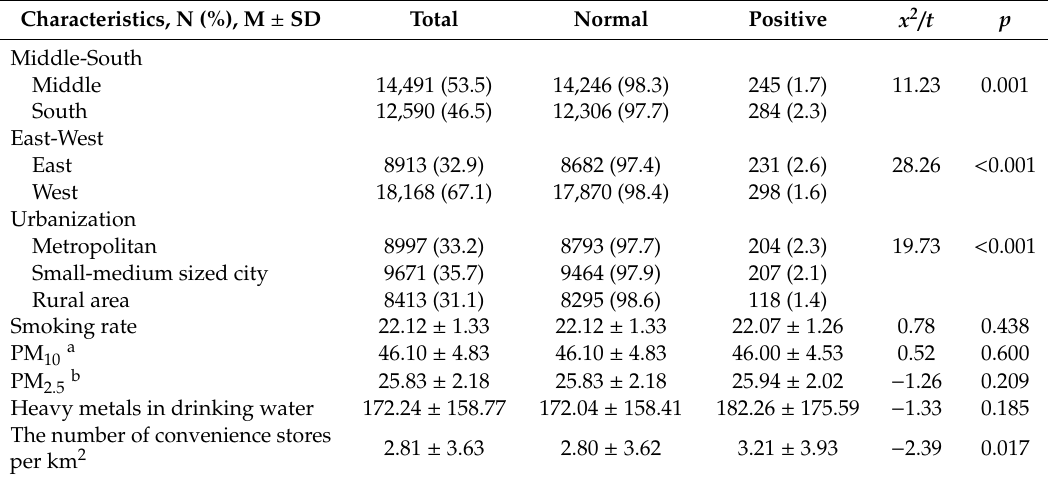
Table 3. Proteinuria by characteristics of region (N =